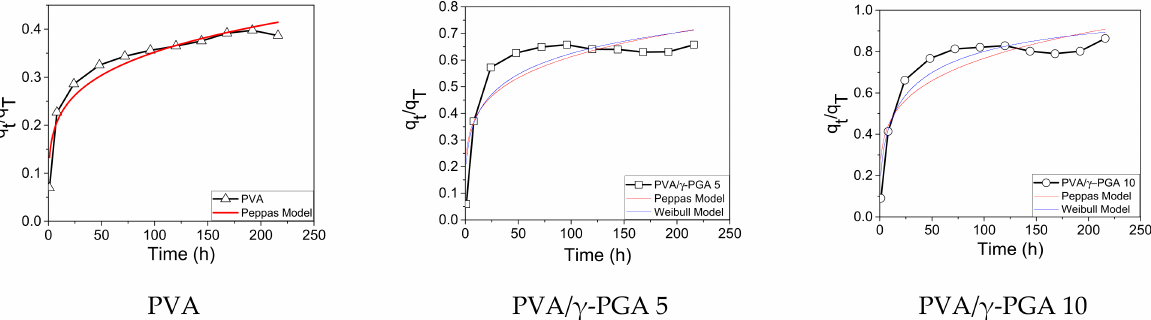
Figure 6. Peppas Model for PVA, PVA/ γ -PGA 5, PVA/ γ -PGA 10, and Weibull model for PVA/ γ -PGA 5, and PVA/ γ - PGA